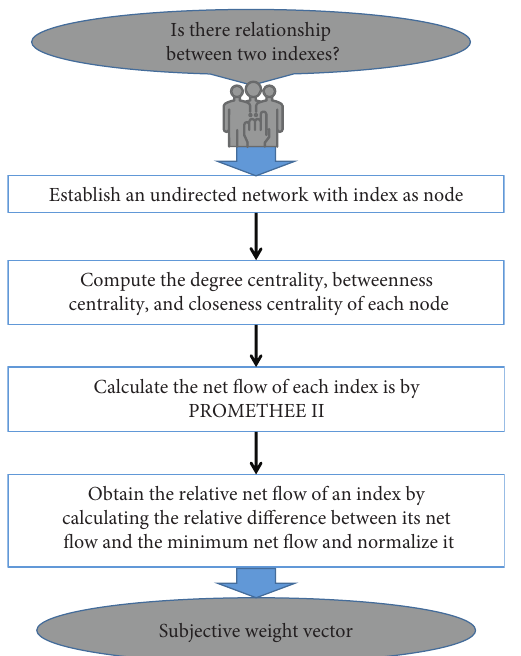
Is there relationship between two indexes?